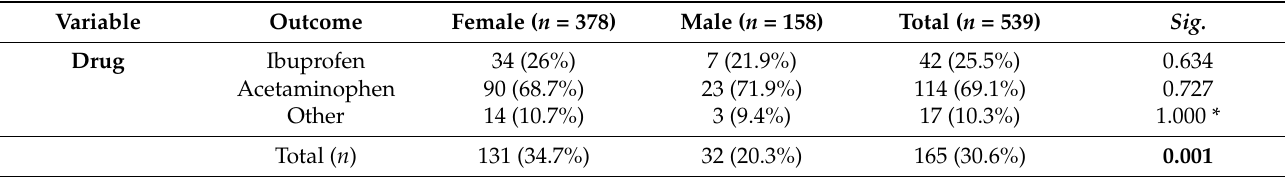
Table 6. Analgesics used by young adults (18–30 years old) receiving mRNA-based COVID-19 vaccines, Czech Republic, April–June 2021 ( n =